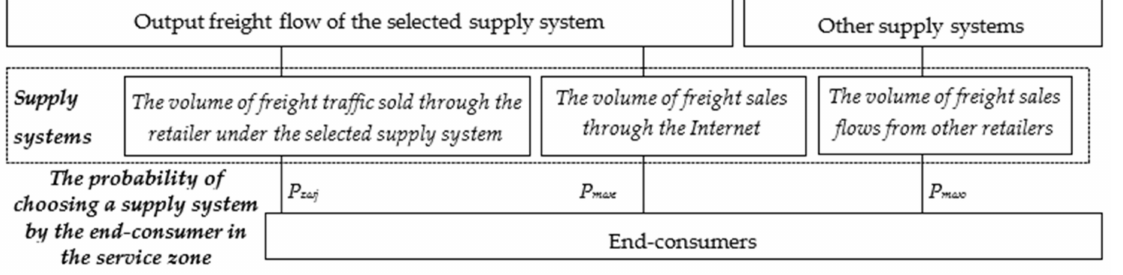
Figure 4. The probability of supply system choice a by end-consumers in the service zone